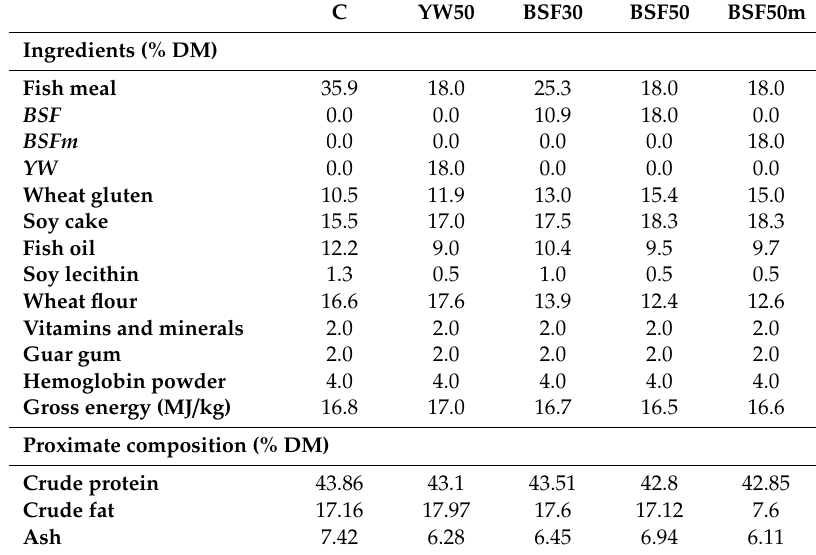
Table 5. Ingredients, proximate composition and gross energy on a dry matter basis (DM) of the experimental